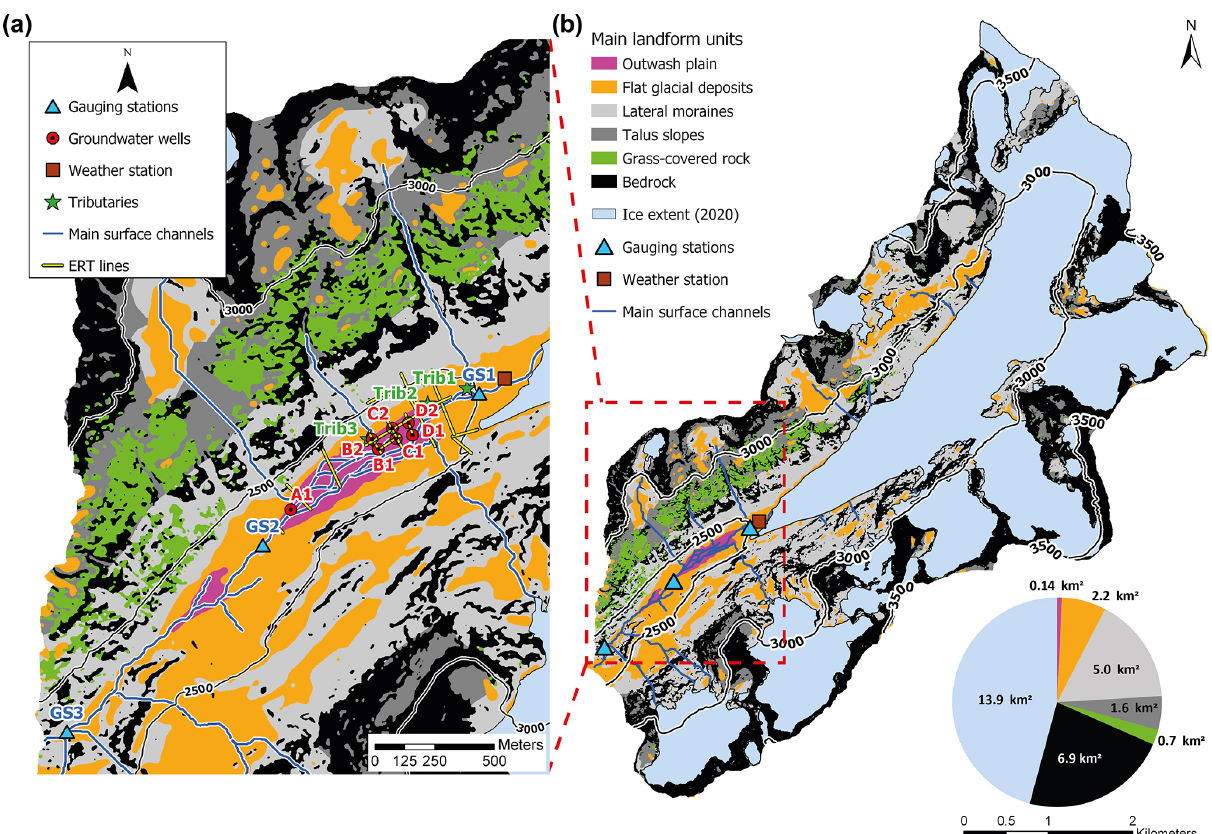
Figure 2. (a) The zoom-in window shows the field measurement stations installed between 2019 and 2021 as well as the ERT lines. The outwash plain is located between gauging stations 1 and 2 (GS1 and GS2). (b) Overview of the Otemma catchment classified based on its main geomorphological landforms (see Sect. 3.4). The pie chart shows the surface area of each